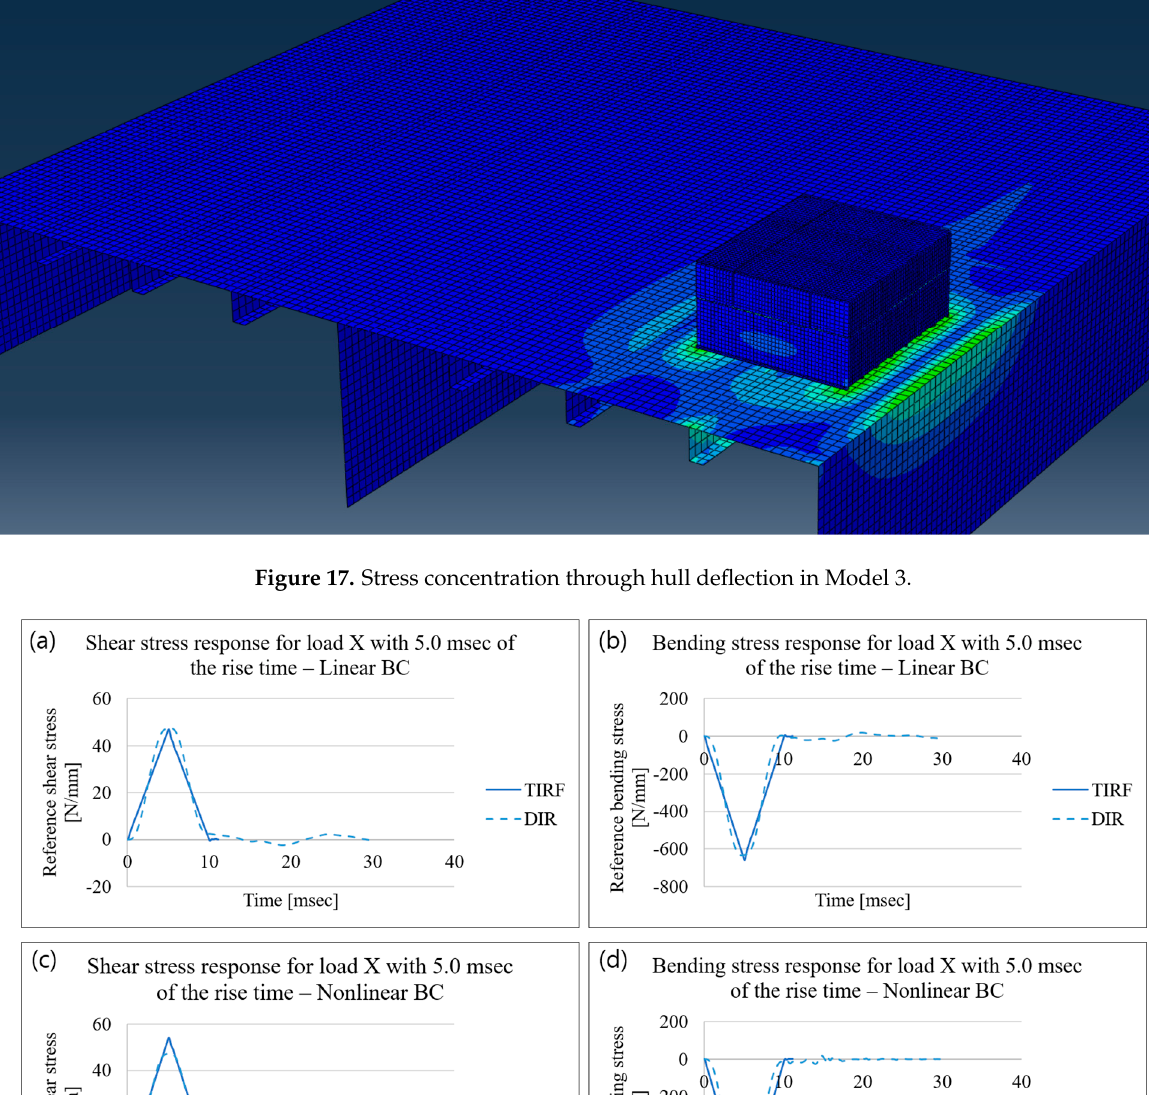
19 of 27 Figure 16. Box and whisker plots for the difference in the peak bending stresses and impulse values using TIRF and DIR. Table 8. Dimension of the LNG carrier hull structure for Model 3. Hull Plate Thickness [mm]